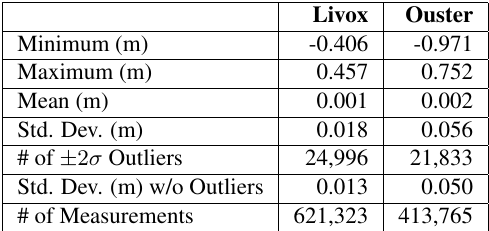
Table 3. Statistics of Planar Residuals after Least Squares Adjustment, Livox Mid-40 and Ouster OSI-64